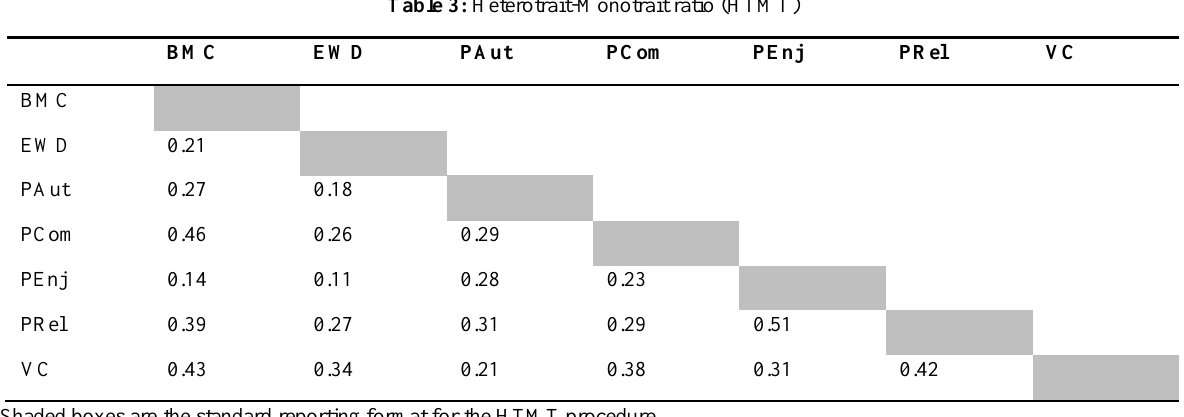
Table 3: Heterotrait-Monotrait ratio